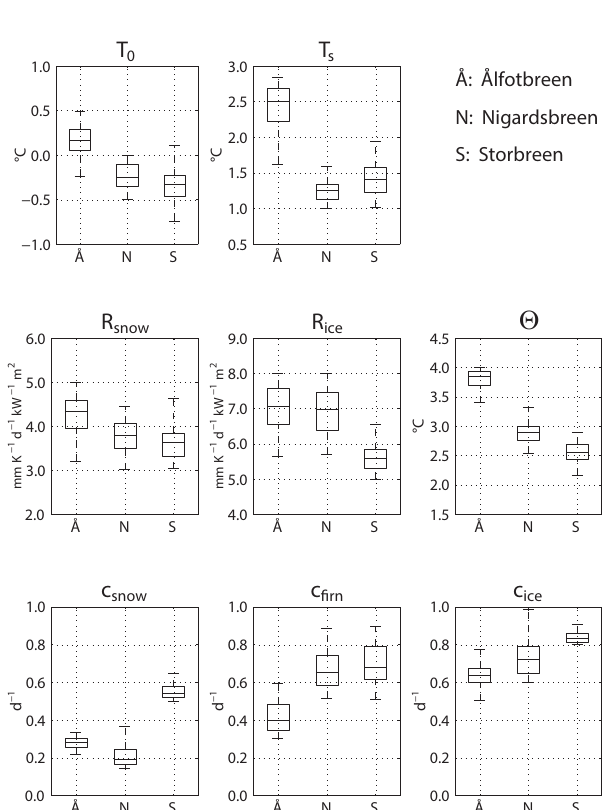
Fig. 3. Parameter uncertainty of the 100 best runs. In each box, the central mark is the median, the edges of the box are the 25 th and 75 th percentiles, the whiskers extend to the most extreme data points. The ordinate indicate the parameter range in the calibration scheme. Parameter description and median values are given in Tab. 3.